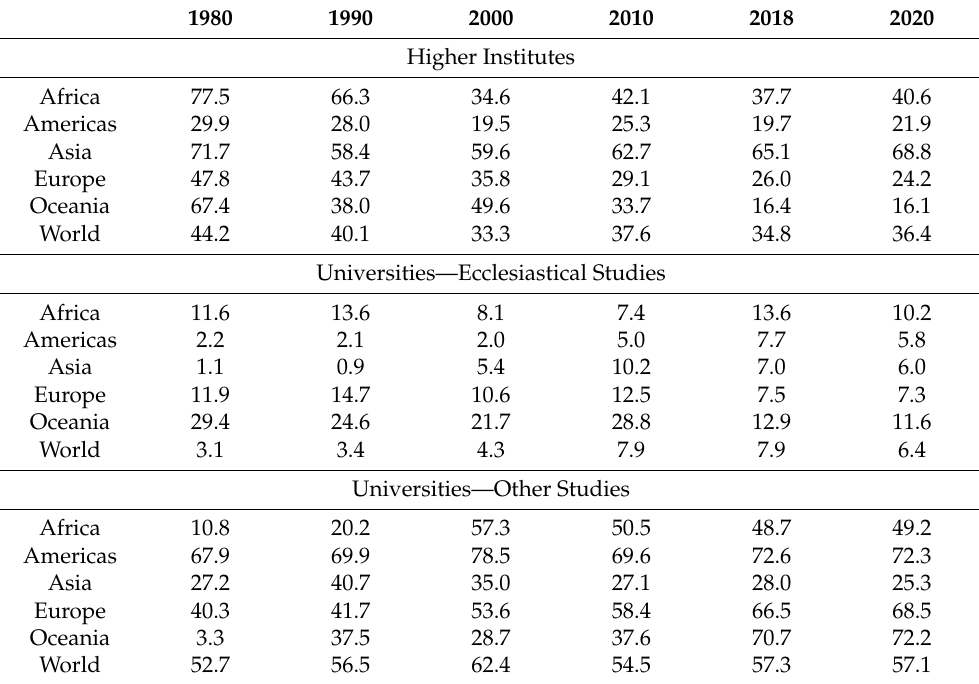
Table 2. Proportion of students enrolled in Catholic institutions of higher education by type (%).